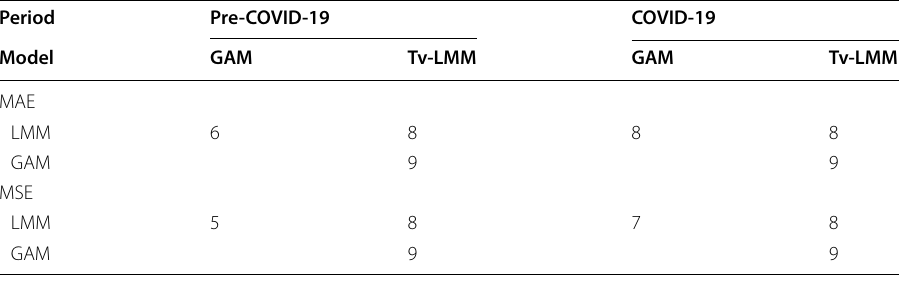
Table 6 The numbers of cryptocurrencies that reject the null hypothesis in terms of the MAE and MSE criteria in-sample procedure during the pre-COVID-19 and COVID-19 periods Period